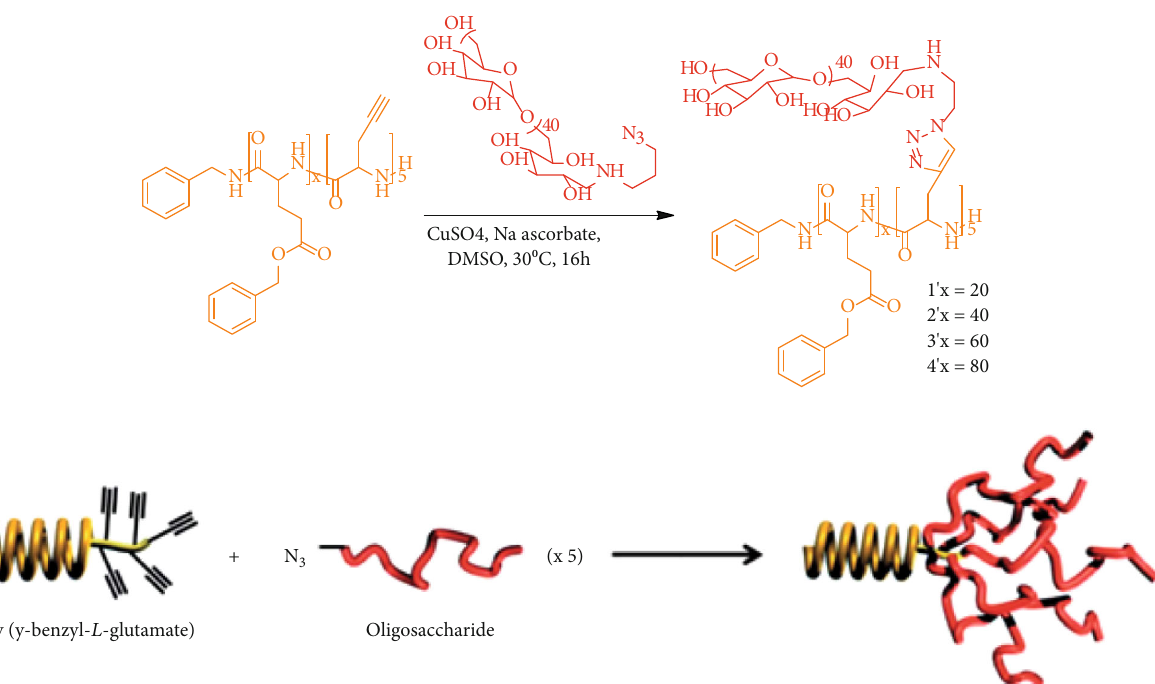
Figure 4: Synthesis of oligosaccharide-based tree-like glycopolypeptide PBLG- b -PPAG